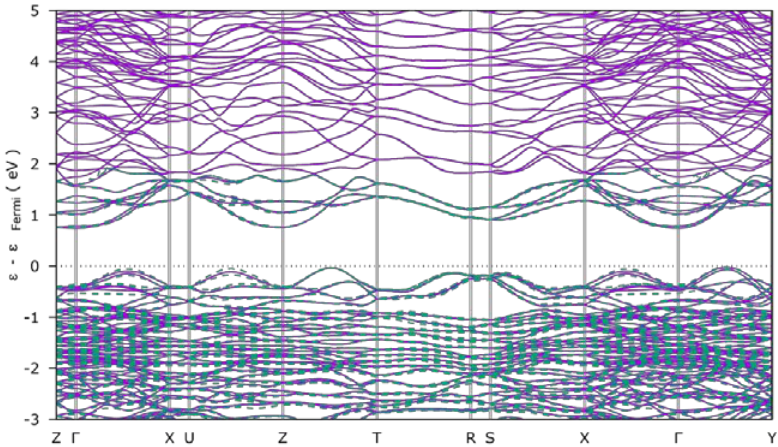
Figure 7. Relativistic (green) and non-relativistic (purple) electronic band structures of BaRh 2 Ge 4 S 4 Te 2 .